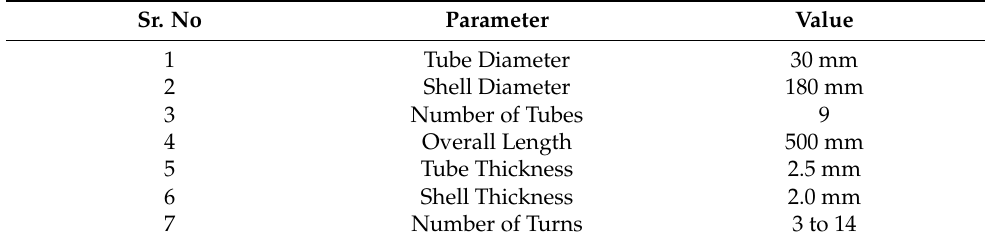
Table 1. Design parameters of the heat